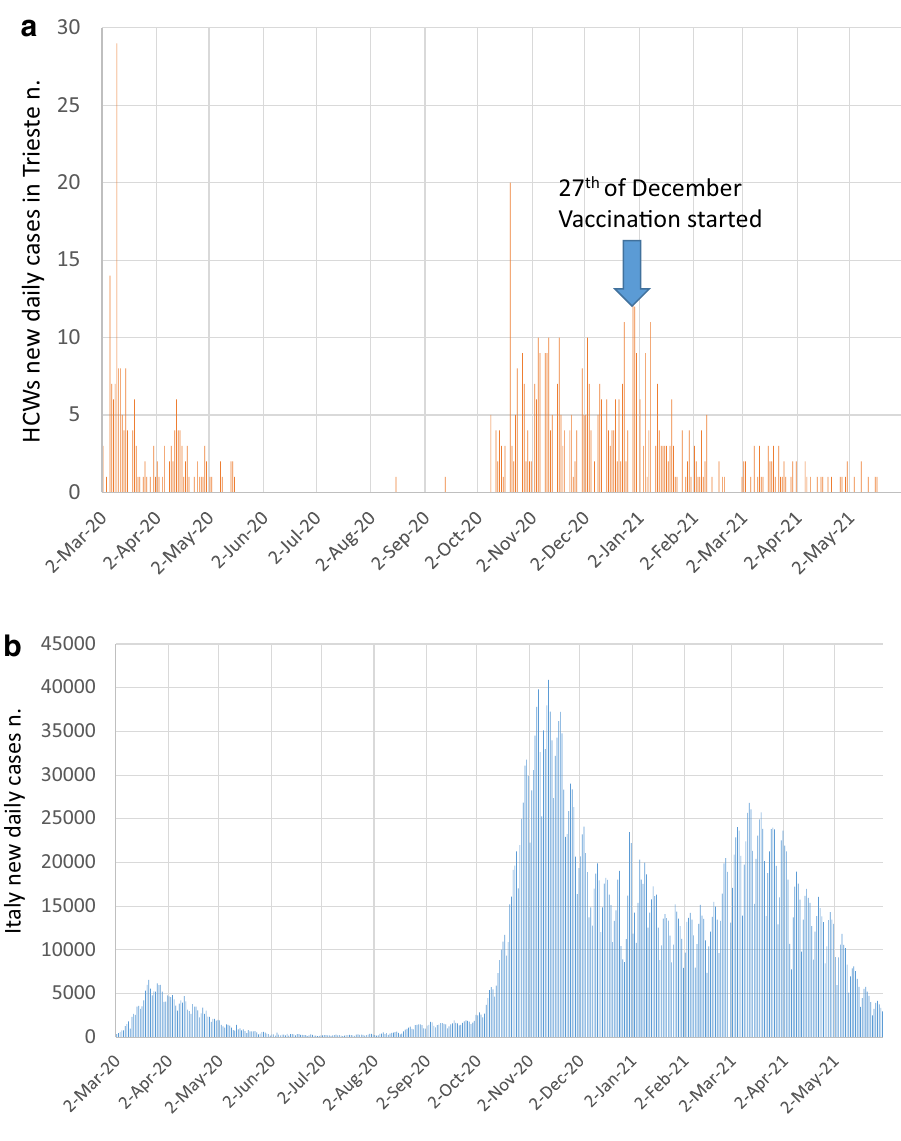
Figure 3. ( a ) Incidence cases of COVID-19 in Italian population from March 1, 2020 to May 31, 2021. ( b ) Incidence cases in health care workers (HCWs) from March 1, 2020 to May 31, 2021.